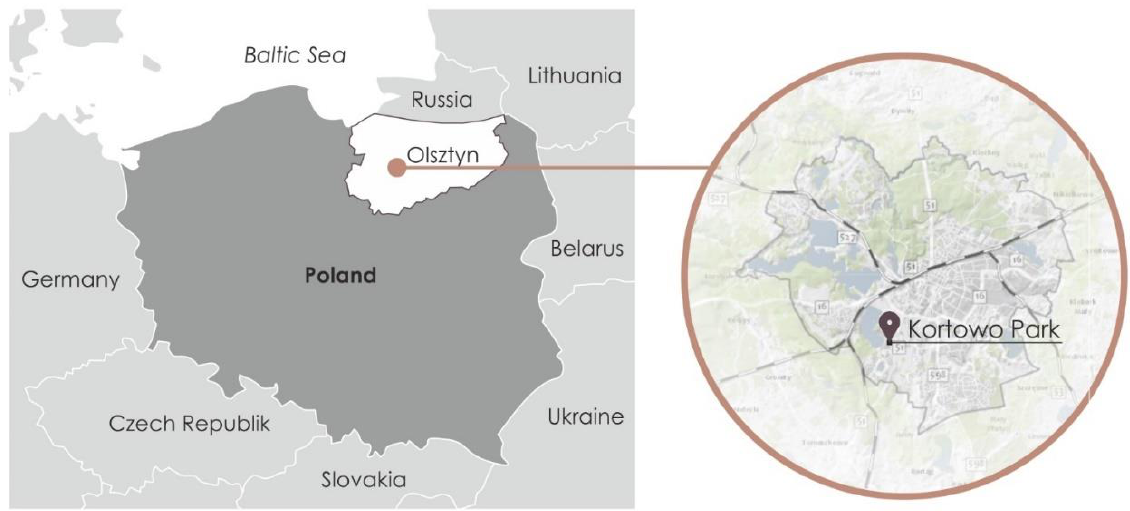
Figure 1. Map with the location of Olsztyn and Kortowo park.